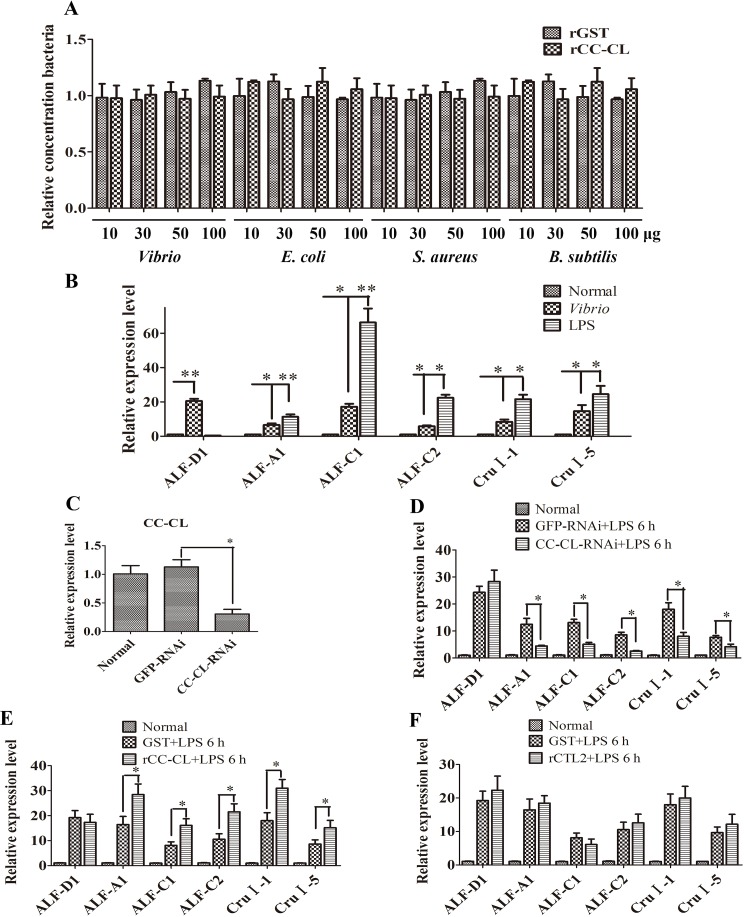
MjCC-CL regulates the expression of AMPs.(A) The rMjCC-CL has no direct bacteriostatic/bacteriocidal activity in vitro. The rMjCC-CL was incubated with V. anguillarum, E. coli, S. aureus or B. subtilis for 24 h. Bacterial growth was evaluated by measuring the absorbance at 600 nm. GST protein was used as control. (B) The expression patterns of 6 AMPs (ALF-A1, ALF-C1, ALF-C2, ALF-D1, CruI-1 and CruI-5) in the intestine of shrimp challenged with V. anguillarum or LPS were analyzed by qRT-PCR. (C) RNAi efficiency after dsMjCC-CL injection was determined using qRT-PCR. (D) The expression of ALF-A1, ALF-C1, ALF-C2, ALF-D1, CruI-1 and CruI-5 in MjCC-CL-RNAi shrimp challenged by LPS was detected with qRT-PCR. GFP-RNAi was used as control. (E) The expression of ALF-A1, ALF-C1, ALF-C2, ALF-D1, CruI-1 and CruI-5 in rMjCC-CL-injected shrimp was analyzed by qRT-PCR. GST was used as a control. (F) The expression of ALF-A1, ALF-C1, ALF-C2, ALF-D1, CruI-1 and CruI-5 in rCTL2-injected shrimp was analyzed by qRT-PCR. GST was used as control. Differences among the groups were analyzed using a t-test (*p < 0.05, **p < 0.01).